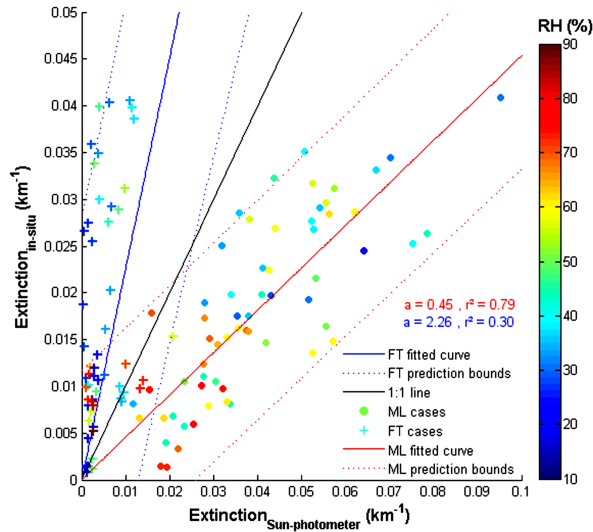
Figure 6. Scatter plot of in situ and sun photometer extinction coef- ficients at 675nm after applying the mixing layer contribution factor to sun photometer measurements. Colours correspond to the mean relative humidity between the two sites. Blue fit and cross markers are for FT data and red fit and circle markers for ML